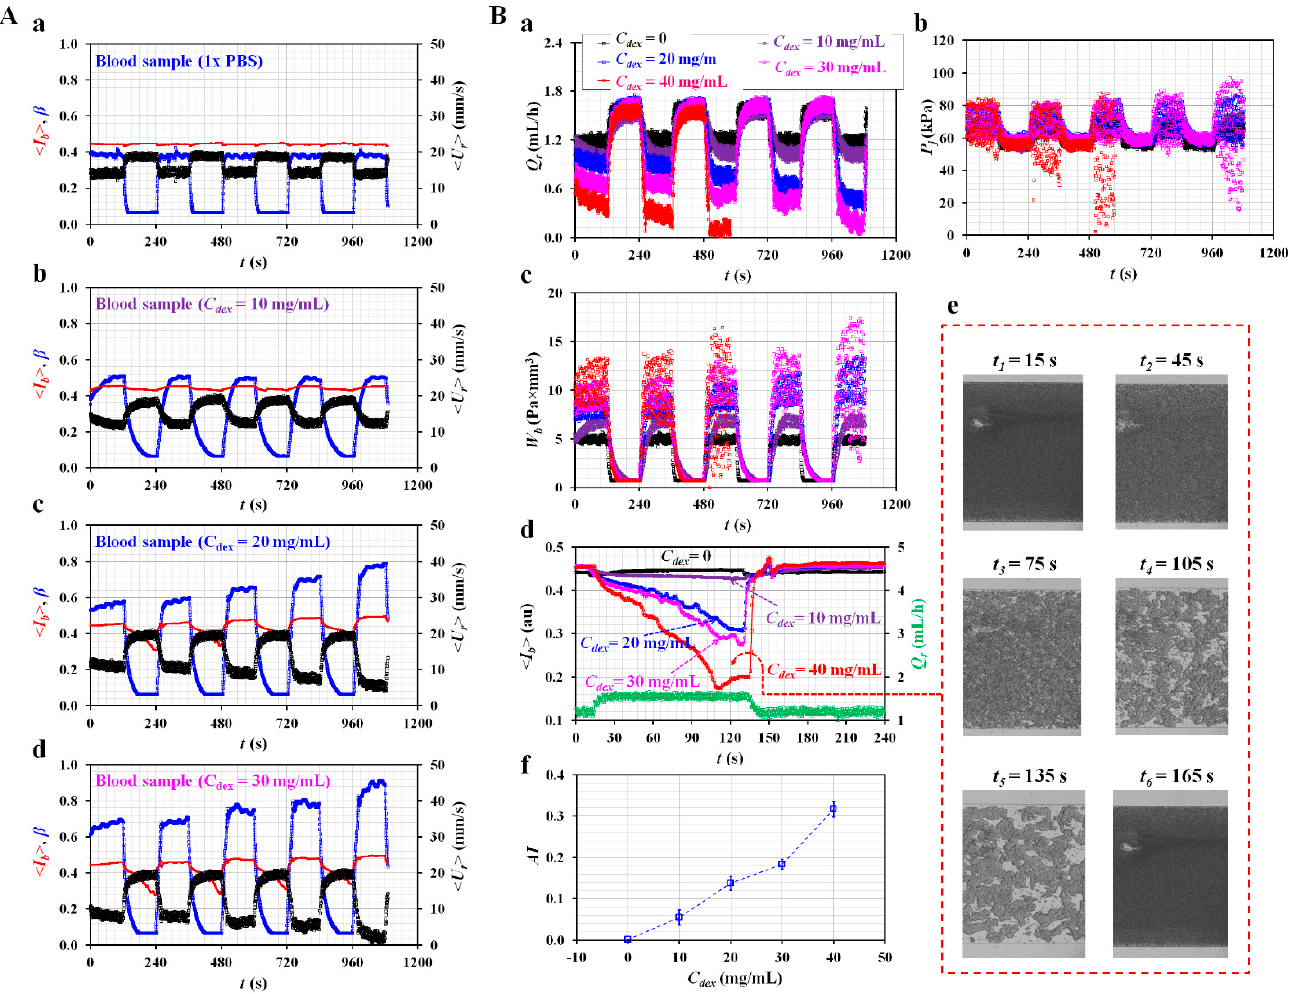
Figure 6. Quantitative evaluations of three biophysical properties of blood sample. ( A ) Temporal variations of < U r >, < I b > and β with respect to concentration of dextran solution ( C dex ) ([ a ] C dex = 0, [ b ] C dex = 10 mg/mL, [ c ] C dex = 20 mg/mL, and [ d ] C dex = 30 mg/mL). ( B ) Contributions of dextran solution to biophysical properties of blood sample (i.e., junction pressure, pressure-induced work, and RBC aggregation). ( a ) Temporal variations of Q r with respect to C dex . ( b ) Temporal variations of P j with respect to C dex . ( c ) Temporal variations of W b with respect to C dex . ( d ) Temporal variations of < I b > with respect to C dex . ( e ) Microscopic images of blood sample ( C dex = 40 mg/mL) captured at a specific time ( t ) ( t = 15, 45, 75, 105, 135, and 165 s). ( f ) Variations of RBC aggregation index ( AI ) with respect to C dex .